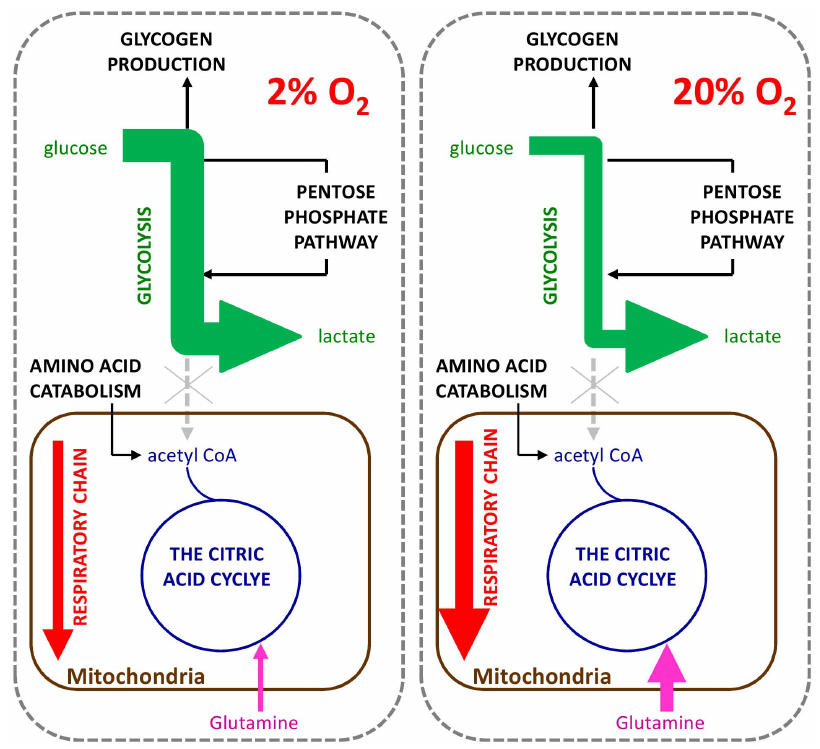
Figure 3. Activity of human embryonic stem cells metabolic pathways cultured at physiological and atmospheric oxygen concentrations. A visual representation of the flux through key metabolic pathways of hESCs cultured at both physiological and atmospheric oxygen concentrations. At both oxygen concentrations glycolysis is disconnected from the TCA cycle. The flux through the glycolysis pathways is greater at physiological oxygen concentrations while the uptake of glutamine and the flux through the respiratory chain is greater at atmospheric oxygen concentrations.